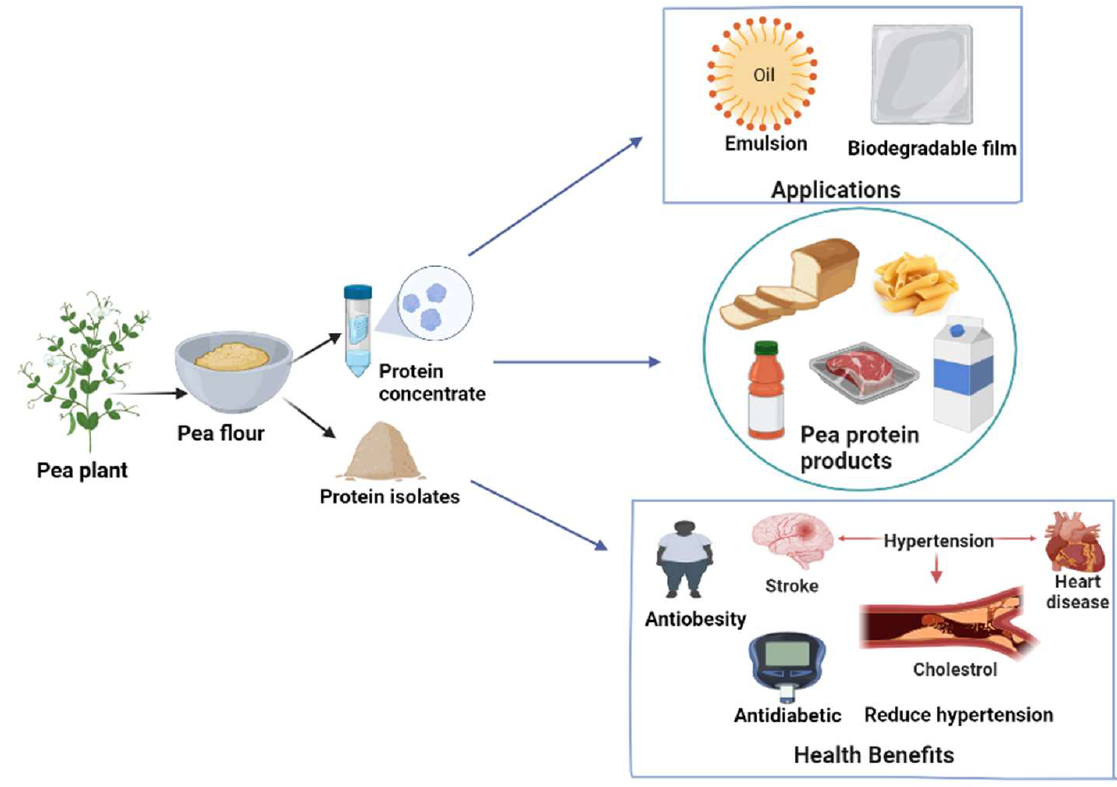
Figure 7. A schematic representation of pea protein applications and their benefits.